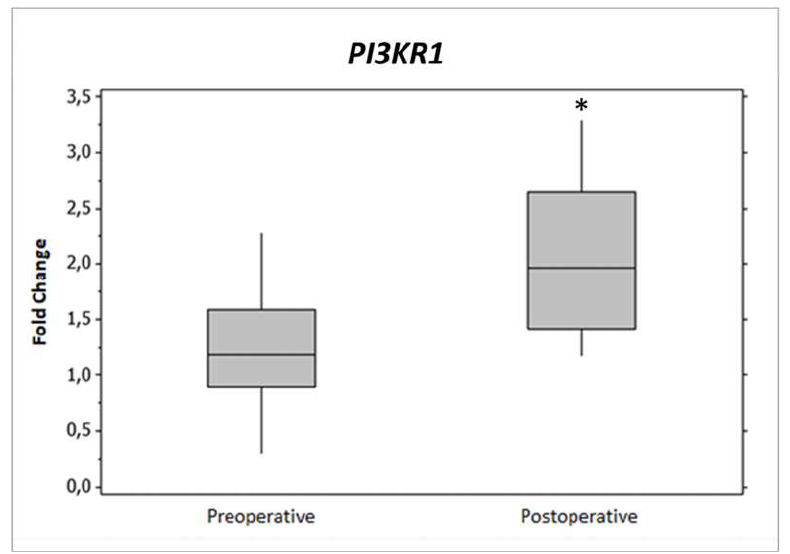
Figure 1. Relative gene expression of phosphoinositide-3-kinase regulatory subunit 1 ( PIK3R1 ) in pre- and postoperative periods. Both periods were composed of 13 patients. The fold change was calculated with the equation 2 −∆∆ C t . * p < 0.05.